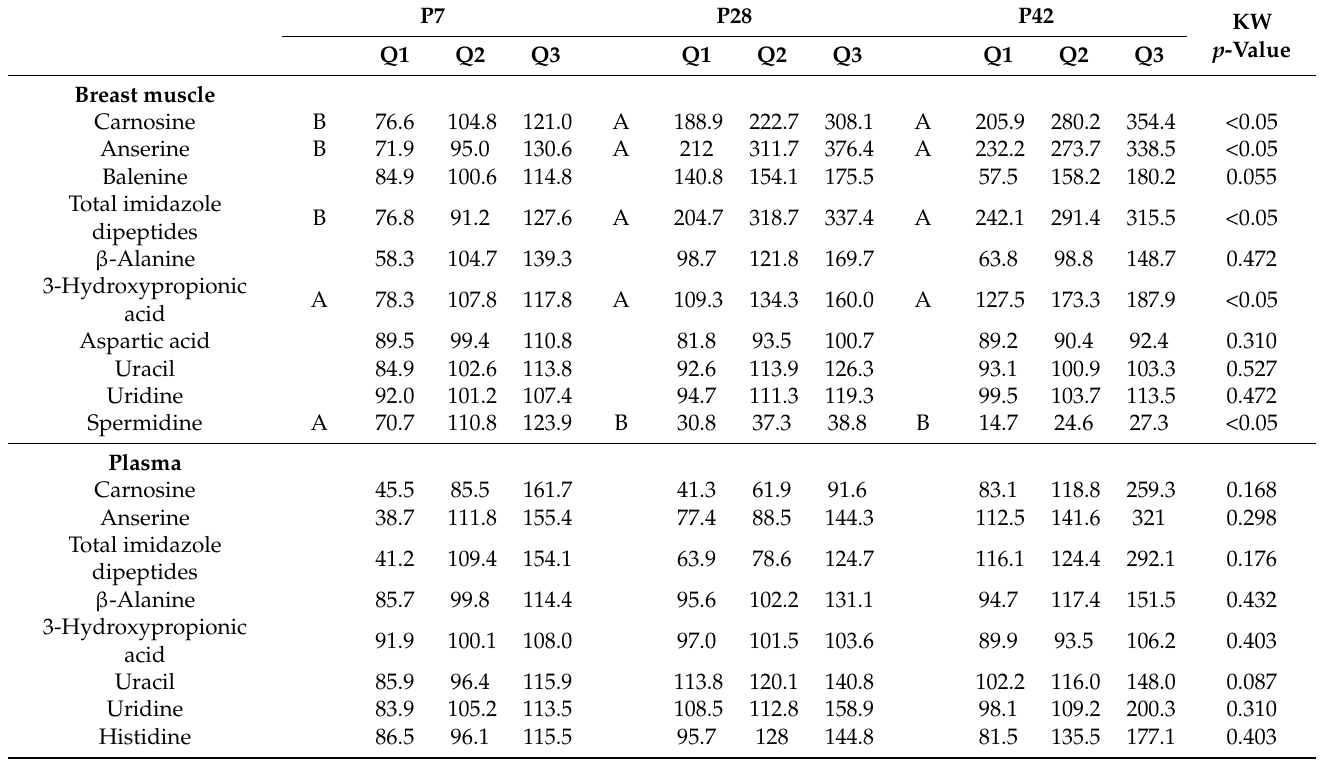
Table 3. Levels of imidazole dipeptides and related metabolites during post-hatch developmental period in chickens.